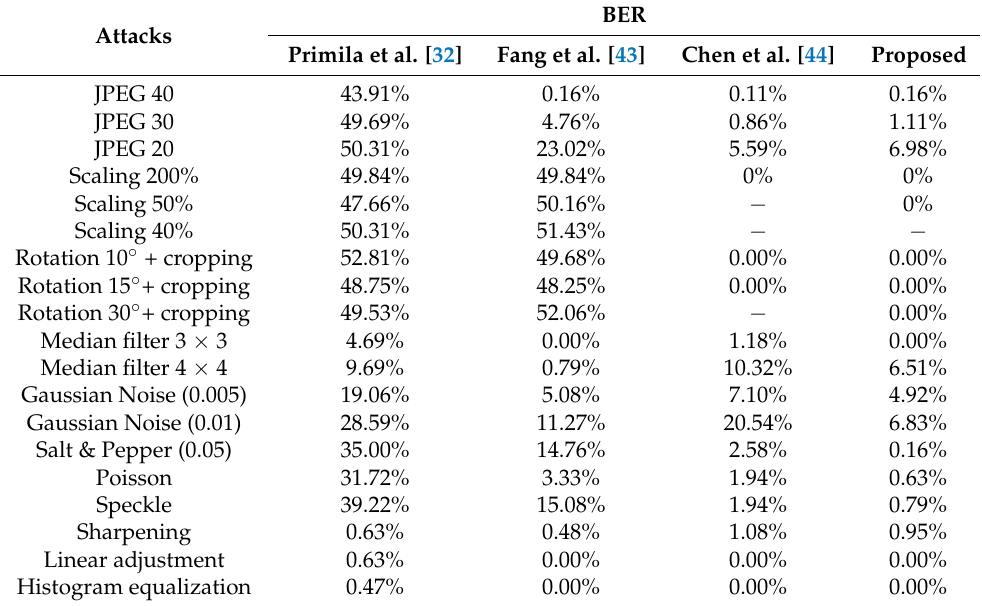
Table 8. Average bit error rate (BER) under different common